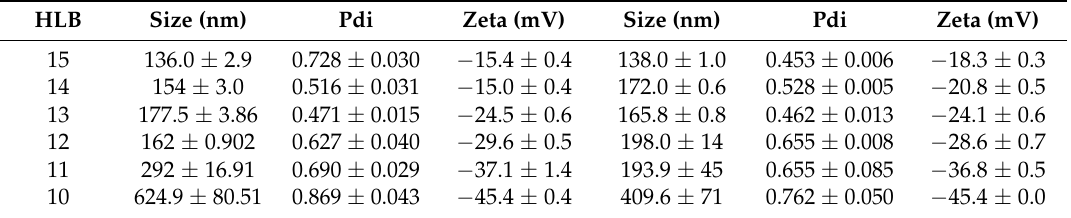
Table 3. Physicochemical characterization of nanoemulsions containing D -limonene.